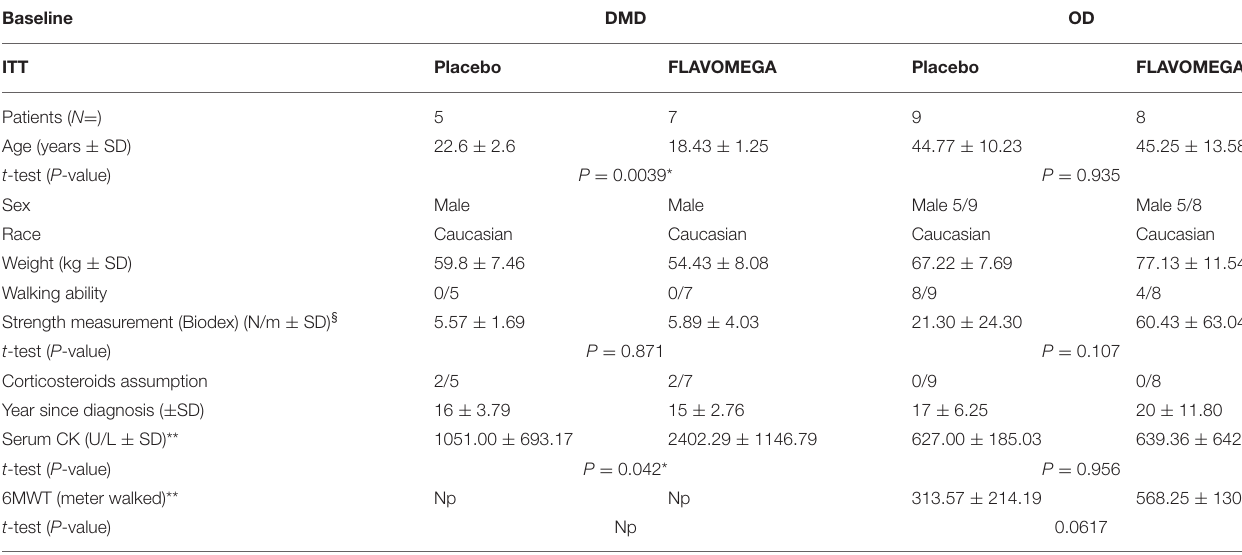
TABLE 4 | Patients features description at